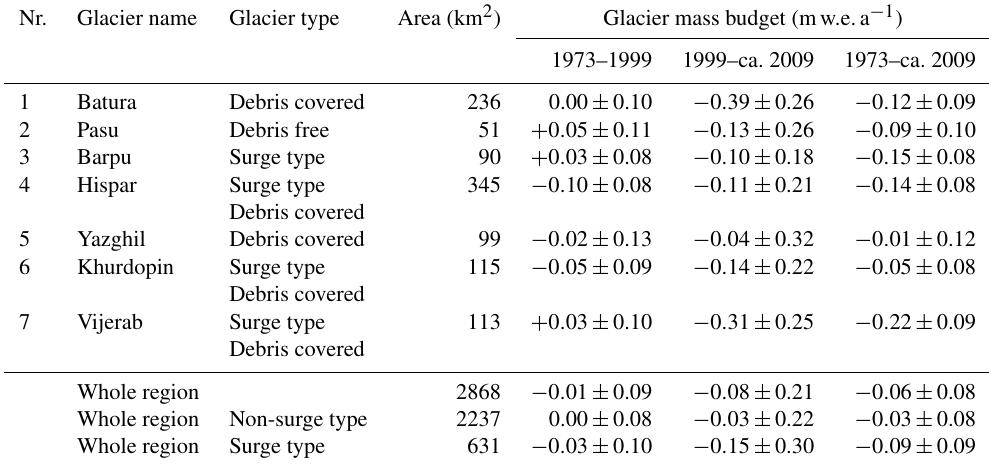
Table 1. Glacier mass budget for different periods, selected glaciers and glacier types.